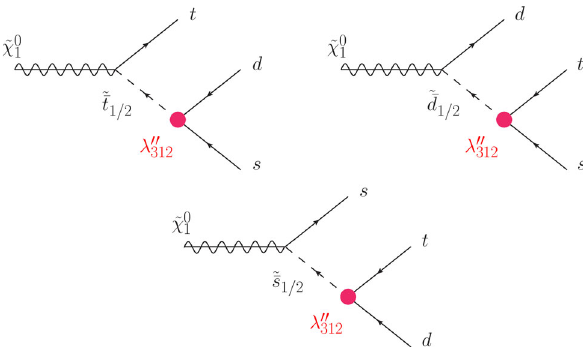
Fig. 1 Neutralino decay diagrams involving the studied R-parity vio- lated couplings